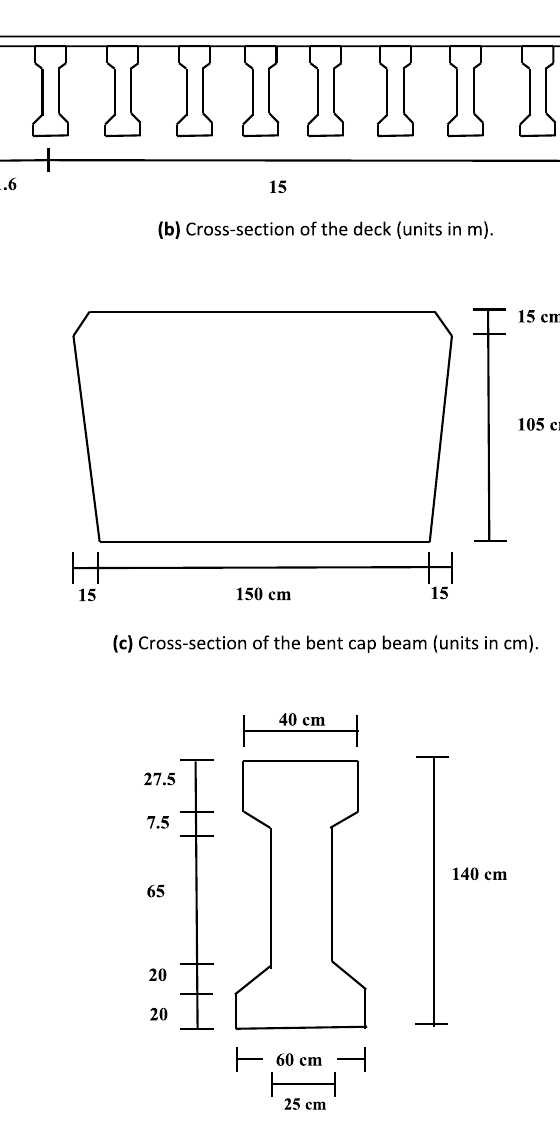
Fig. 1 The plan view and cross‑sections of the existing RC bridge. a Plan view (units in m). b Cross‑section of the deck (units in m). c Cross‑section of the bent cap beam (units in cm). d Cross‑section of the deck beam (units in